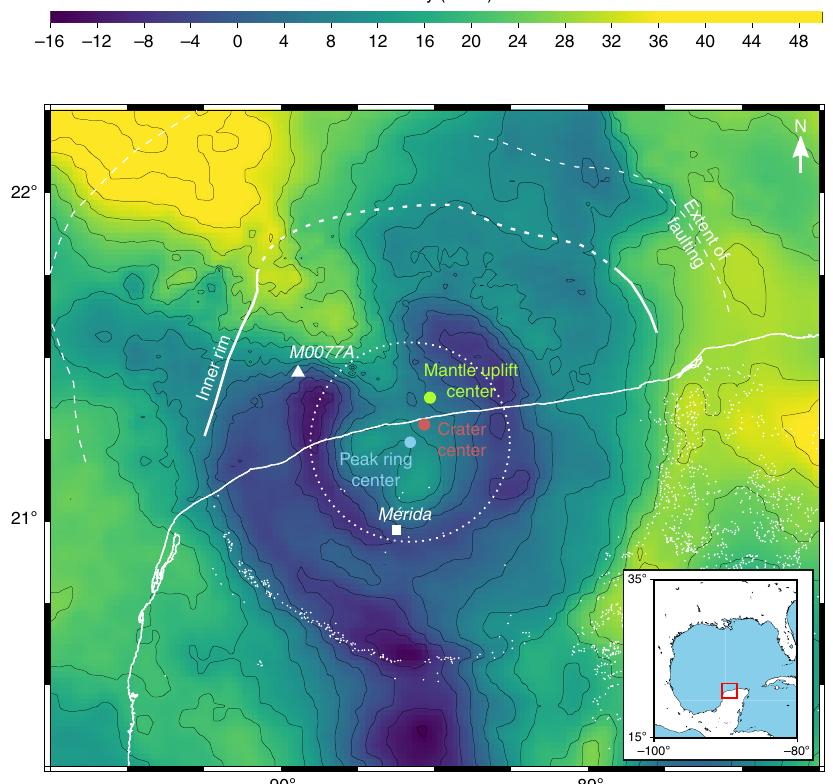
Fig. 1 Asymmetries of the geophysical signature of the Chicxulub crater. Background colourmap shows Bouguer gravity anomaly map in the vicinity of the crater (gravity data courtesy of Hildebrand and Pilkington). The red circle marks the nominal position of the crater centre; the green circle marks the centre of maximum mantle uplift; the blue circle marks the centre of the peak ring (as de fi ned by the annular gravity low surrounding the central high); the white triangle marks the location of the Expedition 364 drill site through the peak ring (Hole M0077A). The coastline is displayed with a thin white line; cenotes and sinkholes with white dots, and the city of Mérida with a white square. The dotted lines offshore mark the approximate location of the inner crater rim and the extent of faulting as imaged by seismic data 14 . Inset depicts the regional setting, with red rectangle outlining the region shown in the gravity map. Adapted from ref. 14